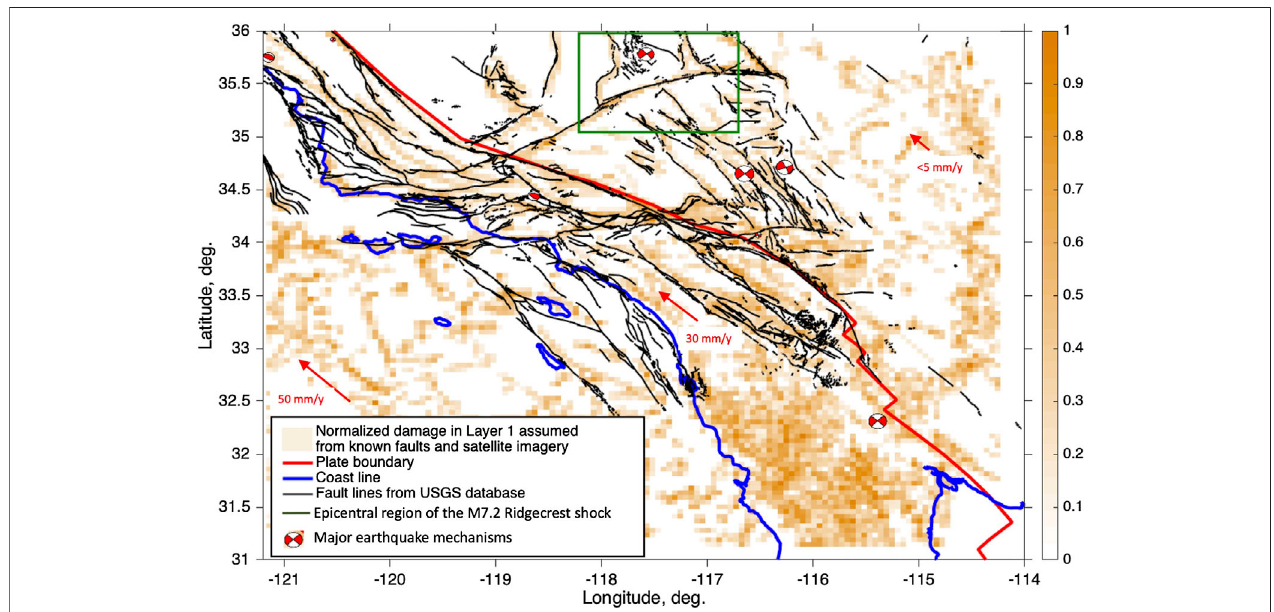
FIGURE 2 | Fault tectonics and crustal destruction pattern (damage function) for the upper model layer. Red arrows show characteristic GPS-measured plate velocities in different parts of the study area.